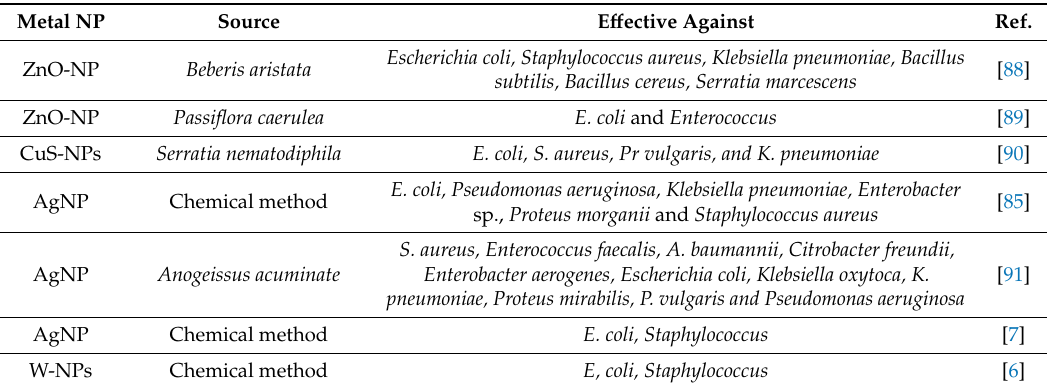
Table 4. Few metallic nanoparticles and their e ff ectiveness against UTI